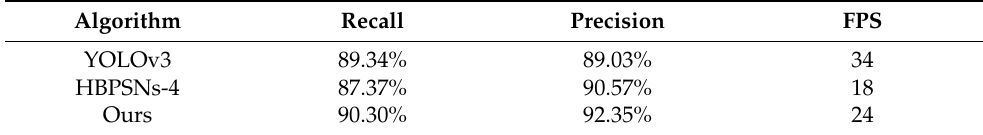
Table 8. Performance Comparison among Different Methods.